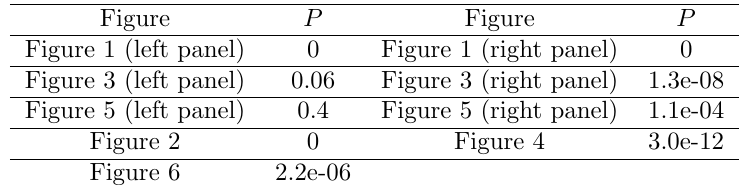
Table 1. The Kolmogorov-Smirnov (KS) test probabilities of Figures 1–6 where two independent distributions in each figure are drawn from the same parent distribution. Figure P Figure P Figure 1 (left panel) 0 Figure 1 (right panel) 0 Figure 3 (left panel) 0.06 Figure 3 (right panel) 1.3e-08 Figure 5 (left panel) 0.4 Figure 5 (right panel) 1.1e-04 Figure 2 0 Figure 4 3.0e-12 Figure 6